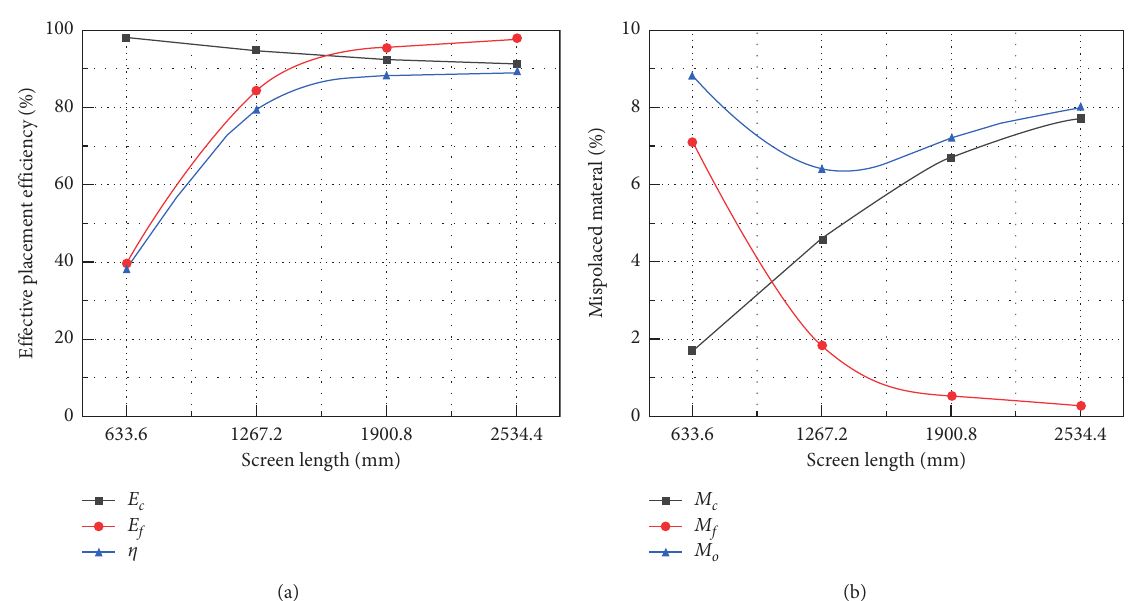
Figure 13: Screening performance of different lengths in the VFFS (a) Effective placement efficiency. (b) Misplaced